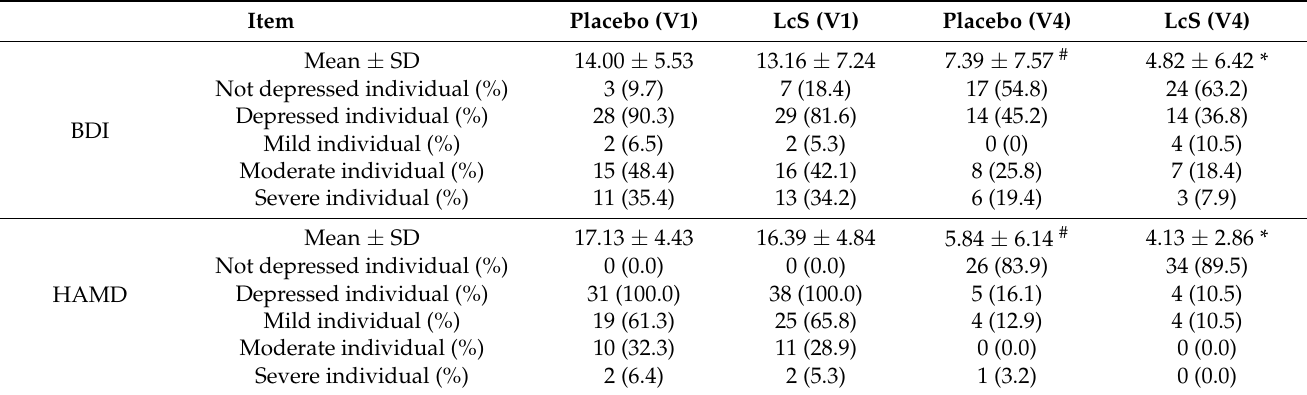
Table 3. The effects of the LcS and placebo on depression.